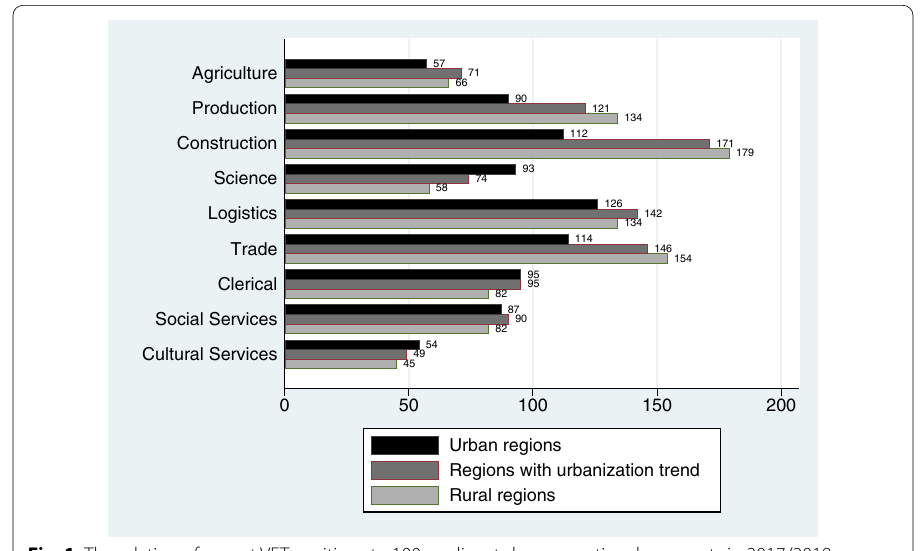
Fig. 1 The relation of vacant VET positions to 100 applicants by occupational segments in 2017/2018. Statistik der Bundesagentur für Arbeit (2019b). The data includes all registered applicants and vacant training positions reported to the Federal Employment Agency. The typology of regions on the level of spatial planning regions by the Federal Institute for Research on Building, Urban Affairs and Spatial Development (BBSR) accounts for population density and settlement structure (Bundesinstitut für Bau-, Stadt- und Raumforschung